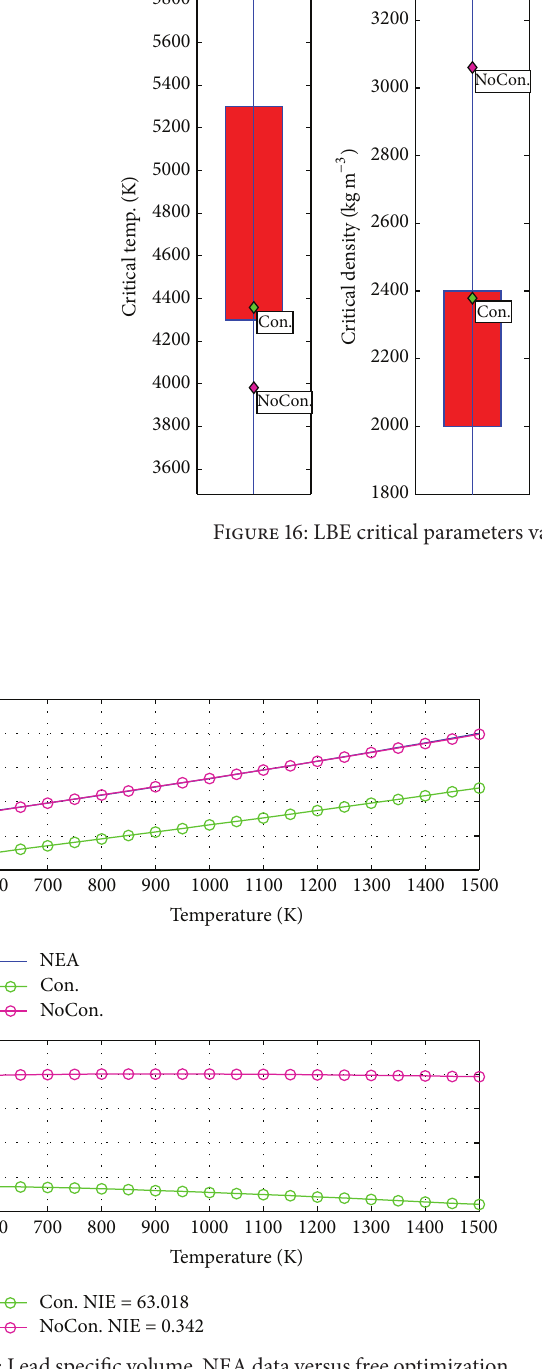
Figure 18: Lead specific enthalpy, NEA data versus constrained and nonconstrained optimization